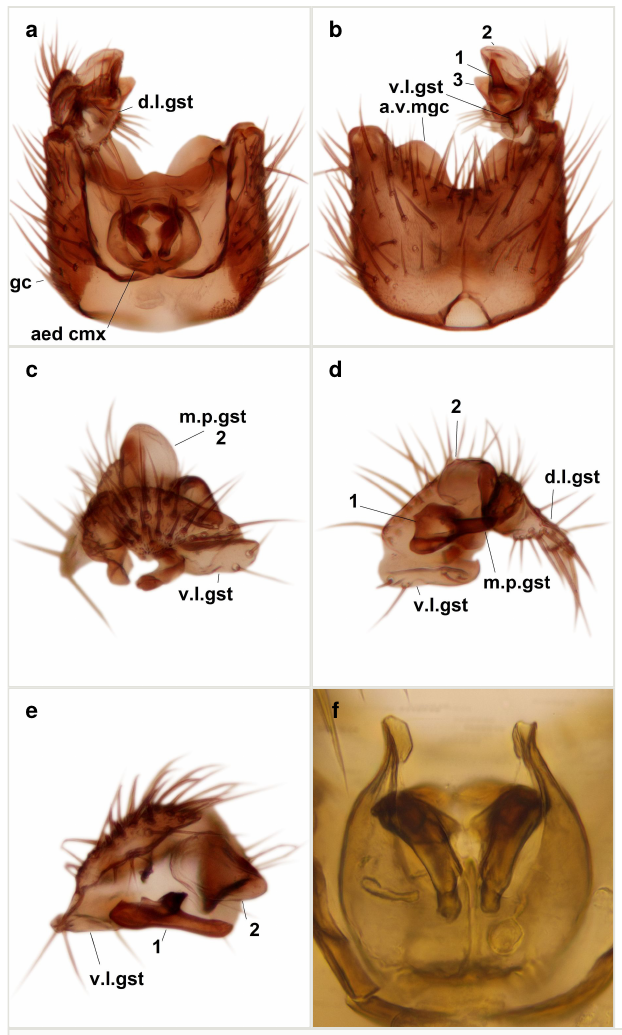
Phronia sompio Salmela sp.n., holotype male, hypopygium. a : Hypopygium, dorsal view. gst=gonostylus, d.l.gst=dorsal lobe of gst, gc=gonocoxites, aed cmx=aedeagal